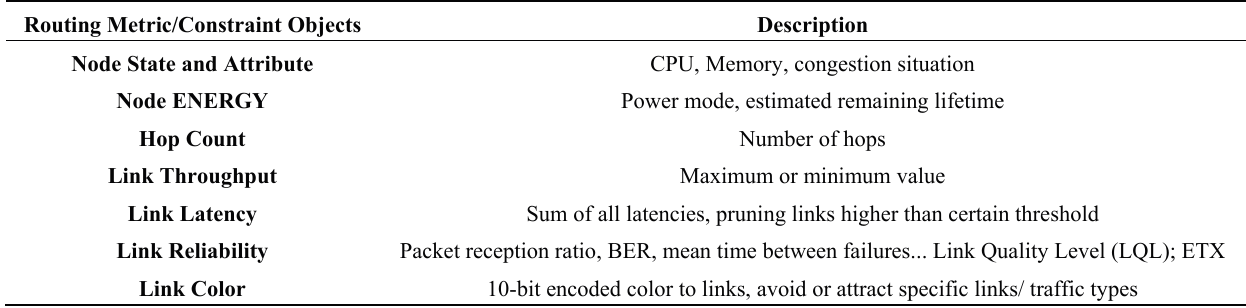
Table 1. A list of routing metric/constraint objects for